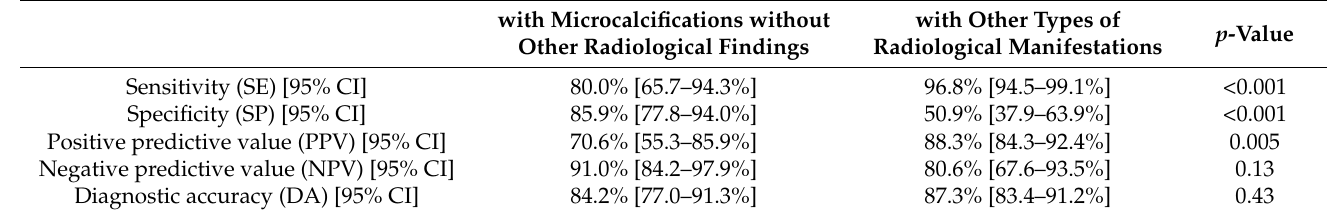
Table 5. Sensitivity, specificity, positive predictive value, negative predictive value, and diagnostic accuracy among lesions with microcalcifications without other radiological findings and with other types of radiological manifestations. Score 0 is predictive of benignity. Scores 1, 2, and 3 are predictive of